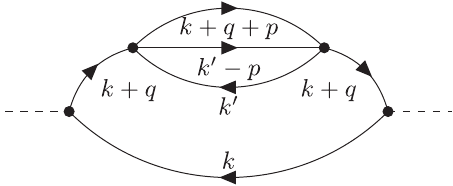
FIG. 2. Linear response to the residual time-dependent poten- tial. In the diagram, the incoming and outgoing dashed lines ˆ ˆ S þ S − represent the operators and attached at the vertices with the q q couplings V and V − , respectively. The vertices connecting four q q solid lines represent the contact s -wave